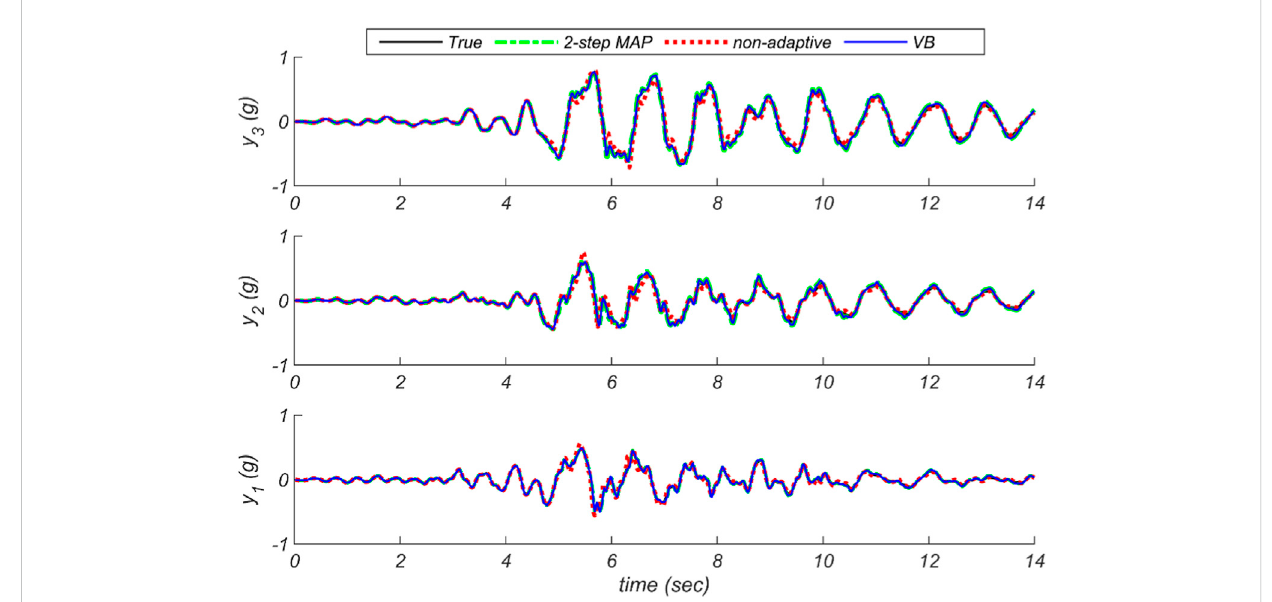
FIGURE 9 Absoluteaccelerationresponsesateach fl oorobtainedbythetruemodelandtheupdatedonesusingthethreemethods:theproposedVBmethod, the two-step marginal MAP estimation method, and the non-adaptive Bayesian method.